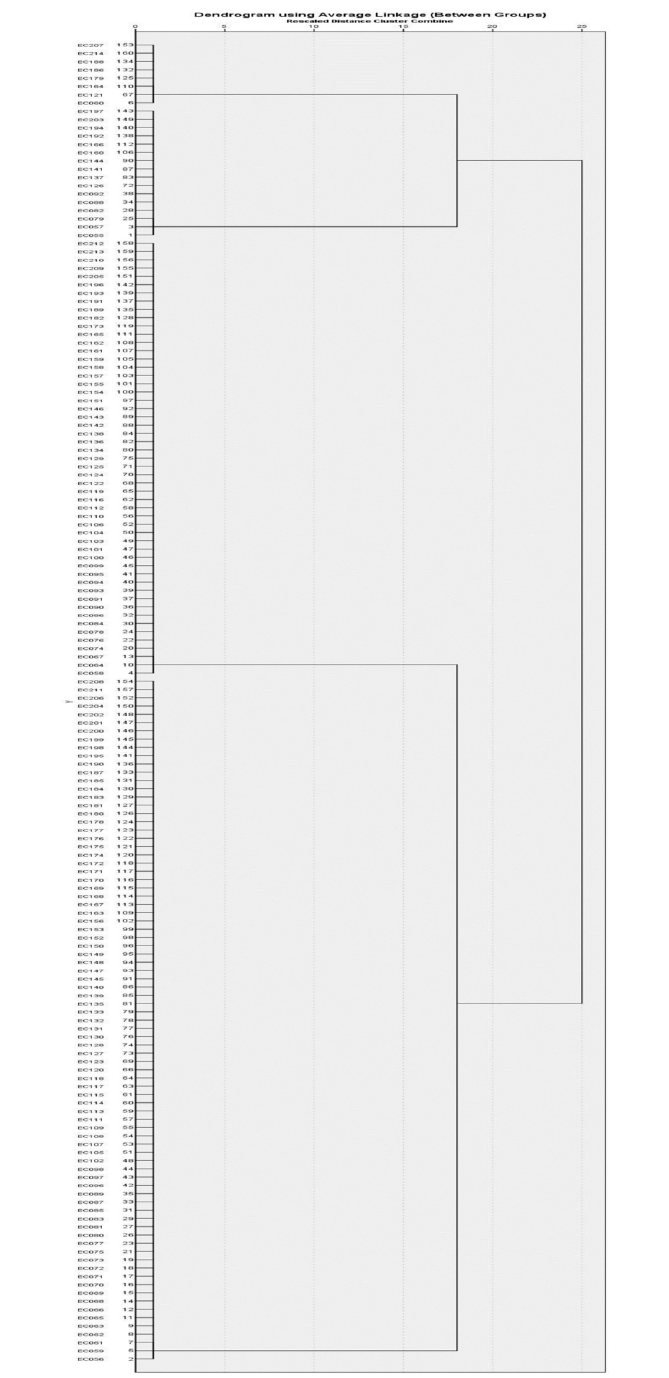
Fig 4. Hierarchical clustering of E . coli isolates according to the presence of capsule production functional virulence genes ( kpsMTII and ompT ).